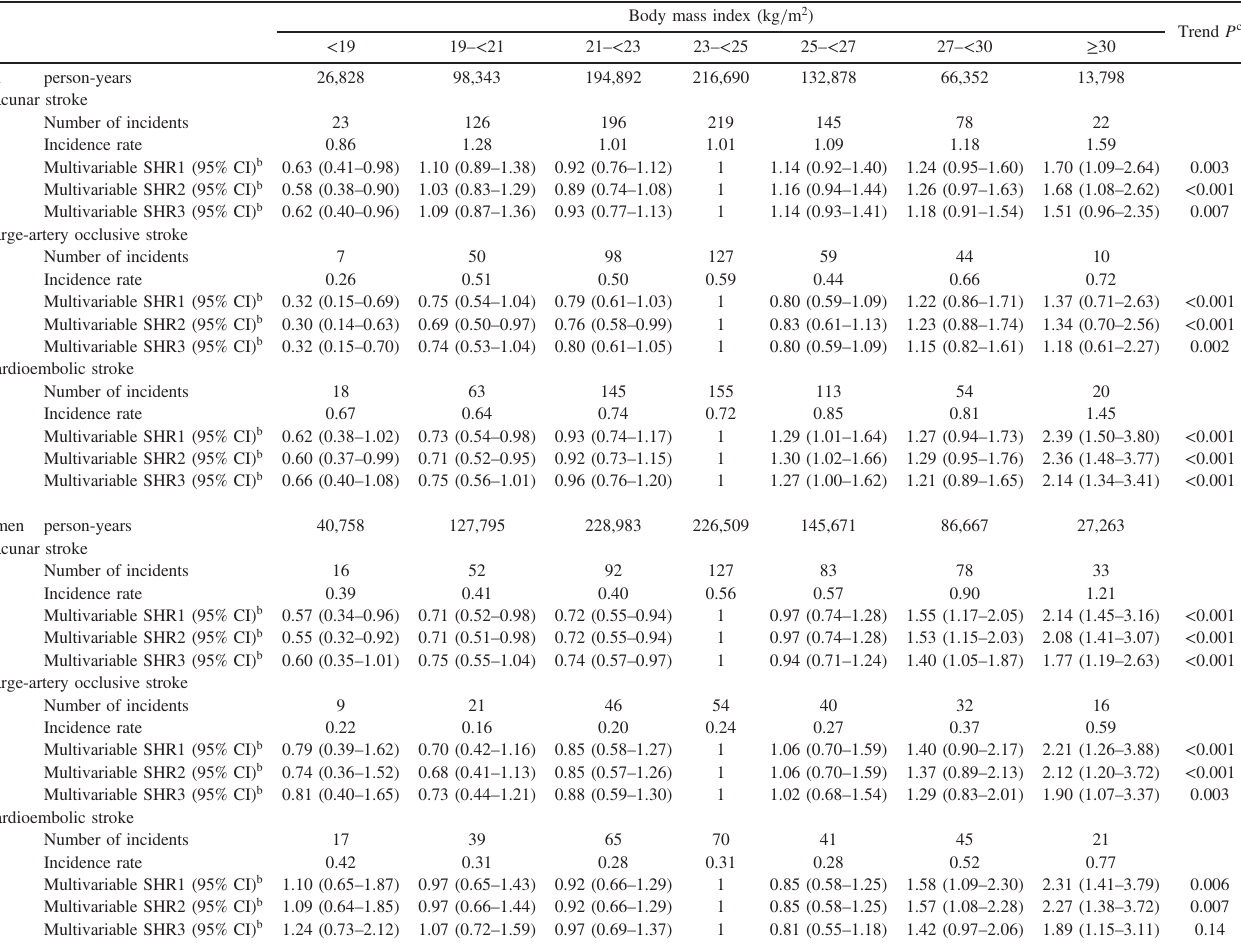
Table 2. Sub-distribution hazard ratios and 95% con fi dence intervals of incident ischemic stroke subtypes according to categories of cumulative average body mass